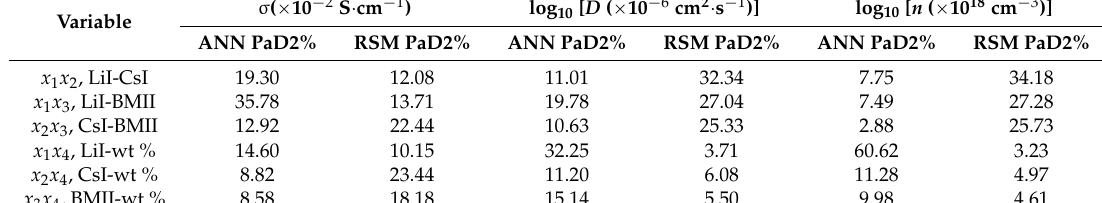
Table 4. PaD2 relative importance of two-way interactions towards the output response properties of (a) σ ( ˆ 10 ´ 2 S ¨ cm ´ 1 ), (b) log 10 [ D ( ˆ 10 ´ 6 cm 2 ¨ s ´ 1 )], and (c) log 10 [ n ( ˆ 10 18 cm ´ 3 )] in terms of percentages.